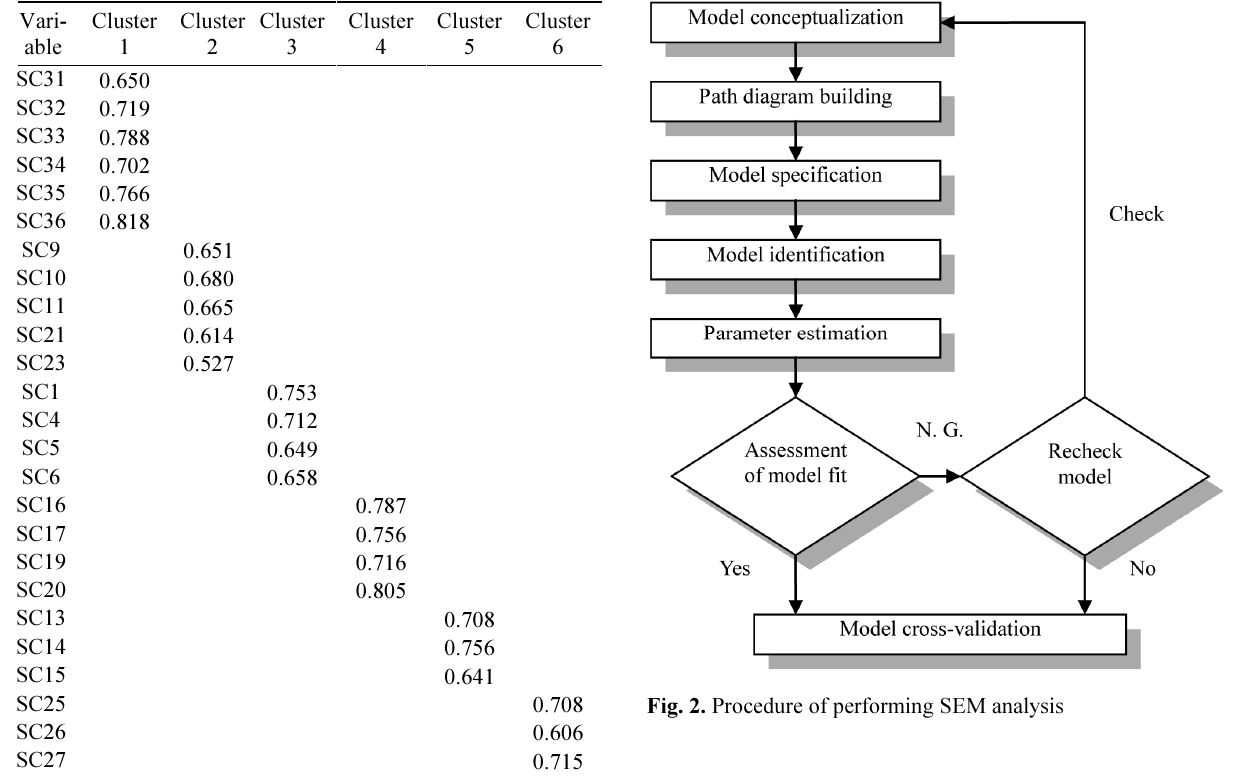
Table 5. Rotated cluster matrix of the 5